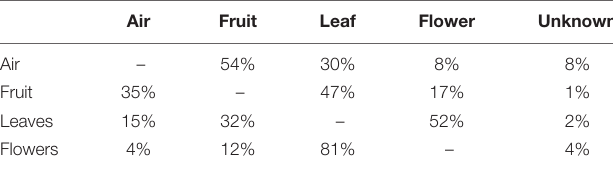
TABLE 1 | Estimated source of fungal communities associated to air, fruit, leaves, and flowers (read data according to the first